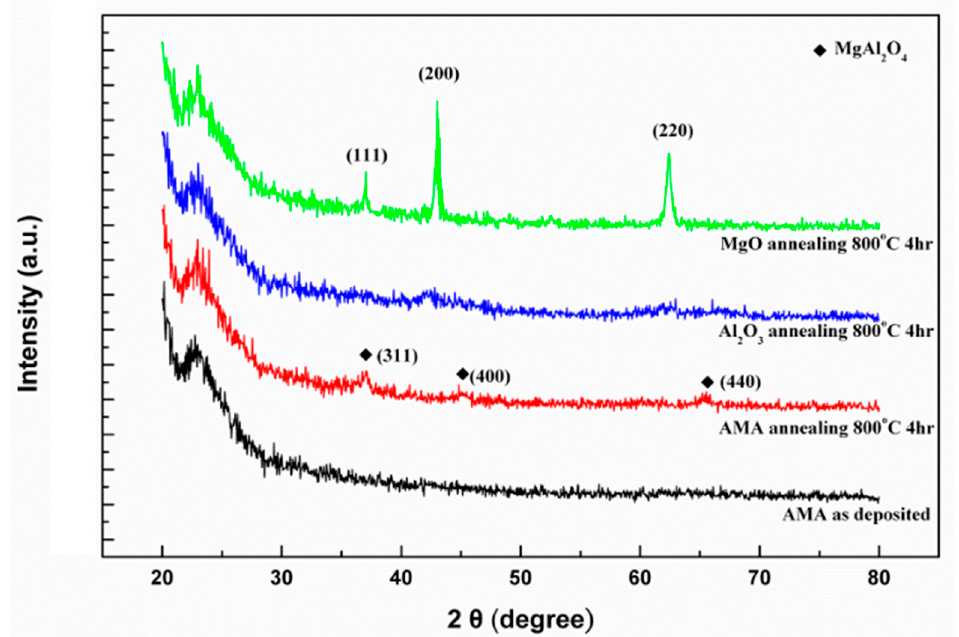
Figure 3. The XRD of Al 2 O 3 , MgO, and Al 2 O 3/ MgO/Al 2 O 3 thin films after a 4-h annealing process at 800 °C.